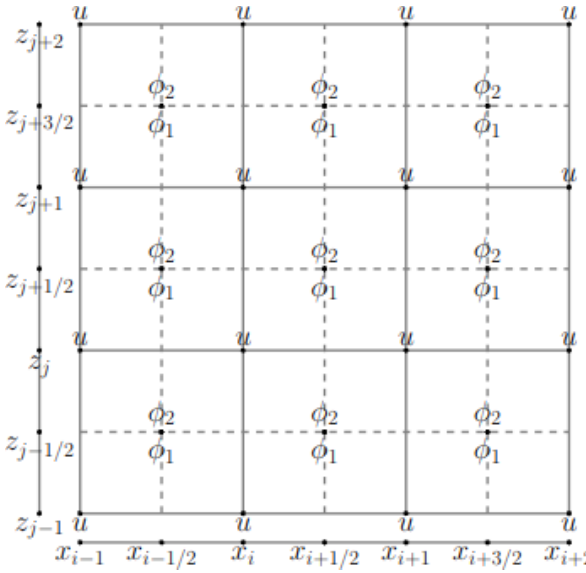
Figure 2. Staggering of variables for PML discretization.